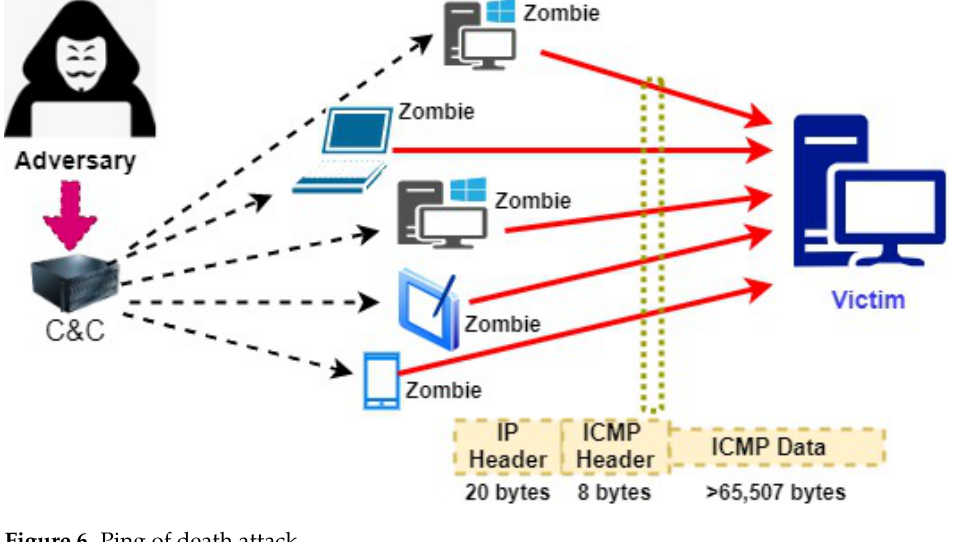
Figure 6. Ping of death